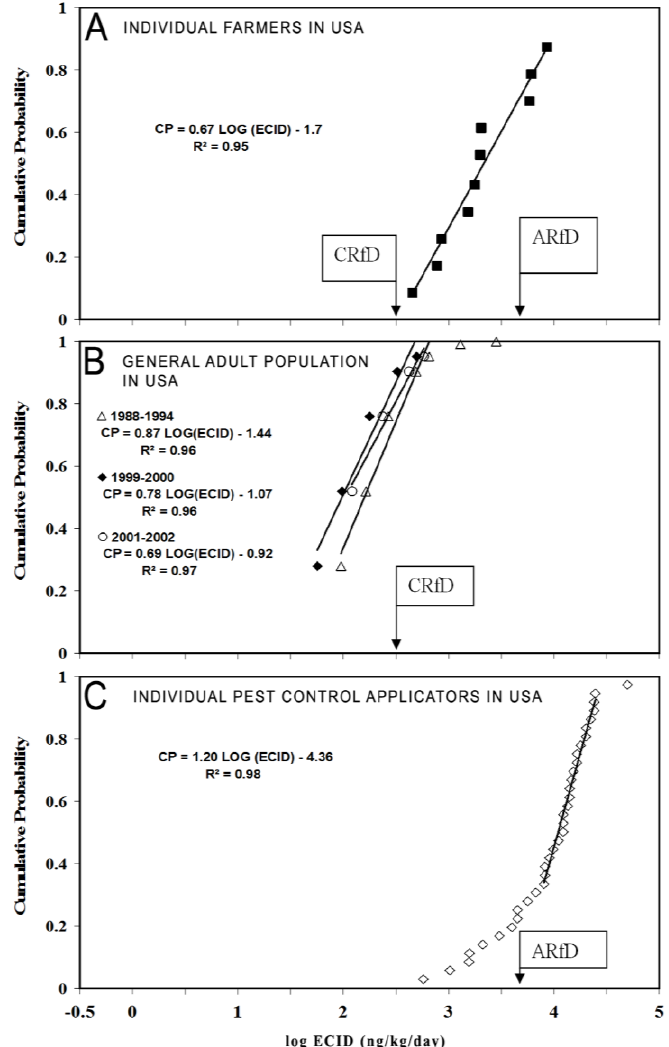
Figure 2. Cumulative probability distribution (CPD) for the Equivalent